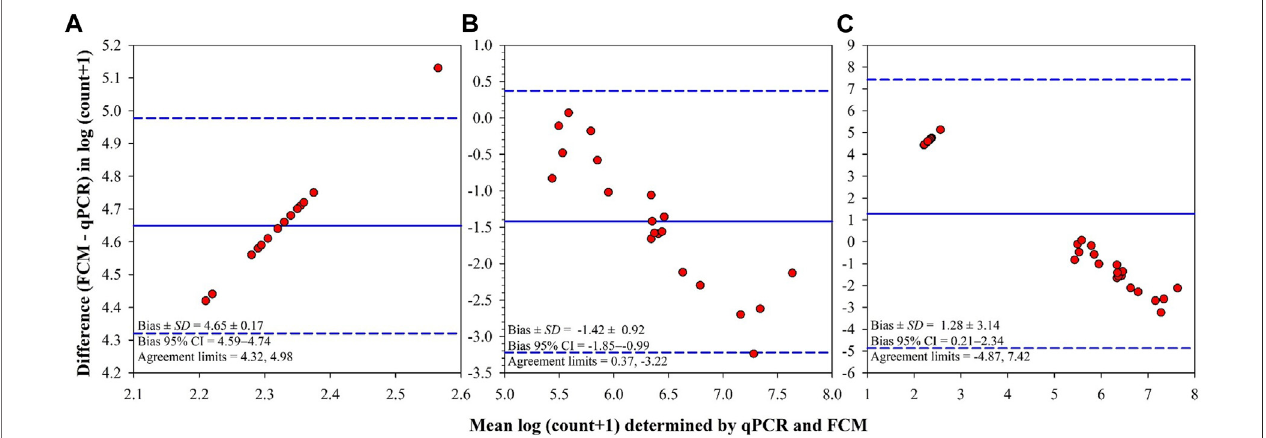
FIGURE 6 | Bland-Altman summaries for F. covae cell counts determined by quantitative PCR (qPCR) and fl ow cytometry (FCM) in the same water samples obtainedfromcontroltanks (A) ,tanksexposedto F.covae challenge (B) ,andalltanks (C) .TheBland-Altmansummariesplotthedifferenceinthemeasure[log(countof F. covae + 1)] between two determination methods (FCM – qPCR; y-axis) versus the mean of the measure determined by the two methods for each subject (x-axis). The overall mean differences (bias; solid lines) and limits of agreement (mean difference ±1.96 standard deviation of the differences; dashed lines) are also shown on the